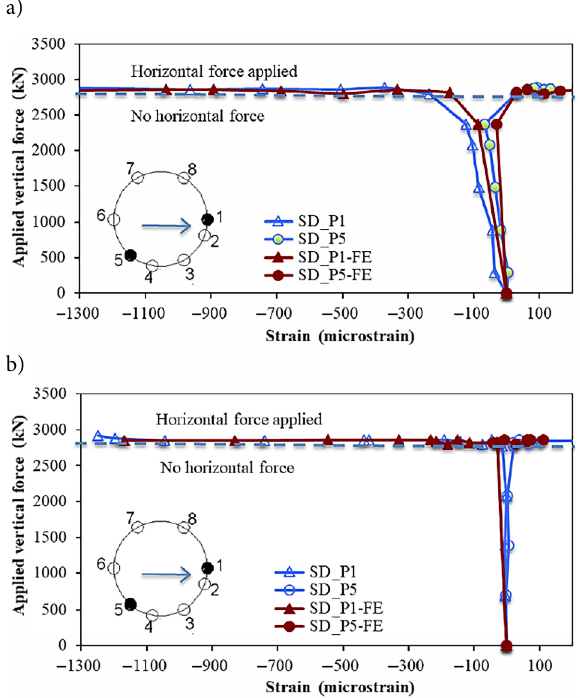
Figure 12. Normal stress versus applied horizontal applied force in column at Section D in Stage 2: a – Type A; b –